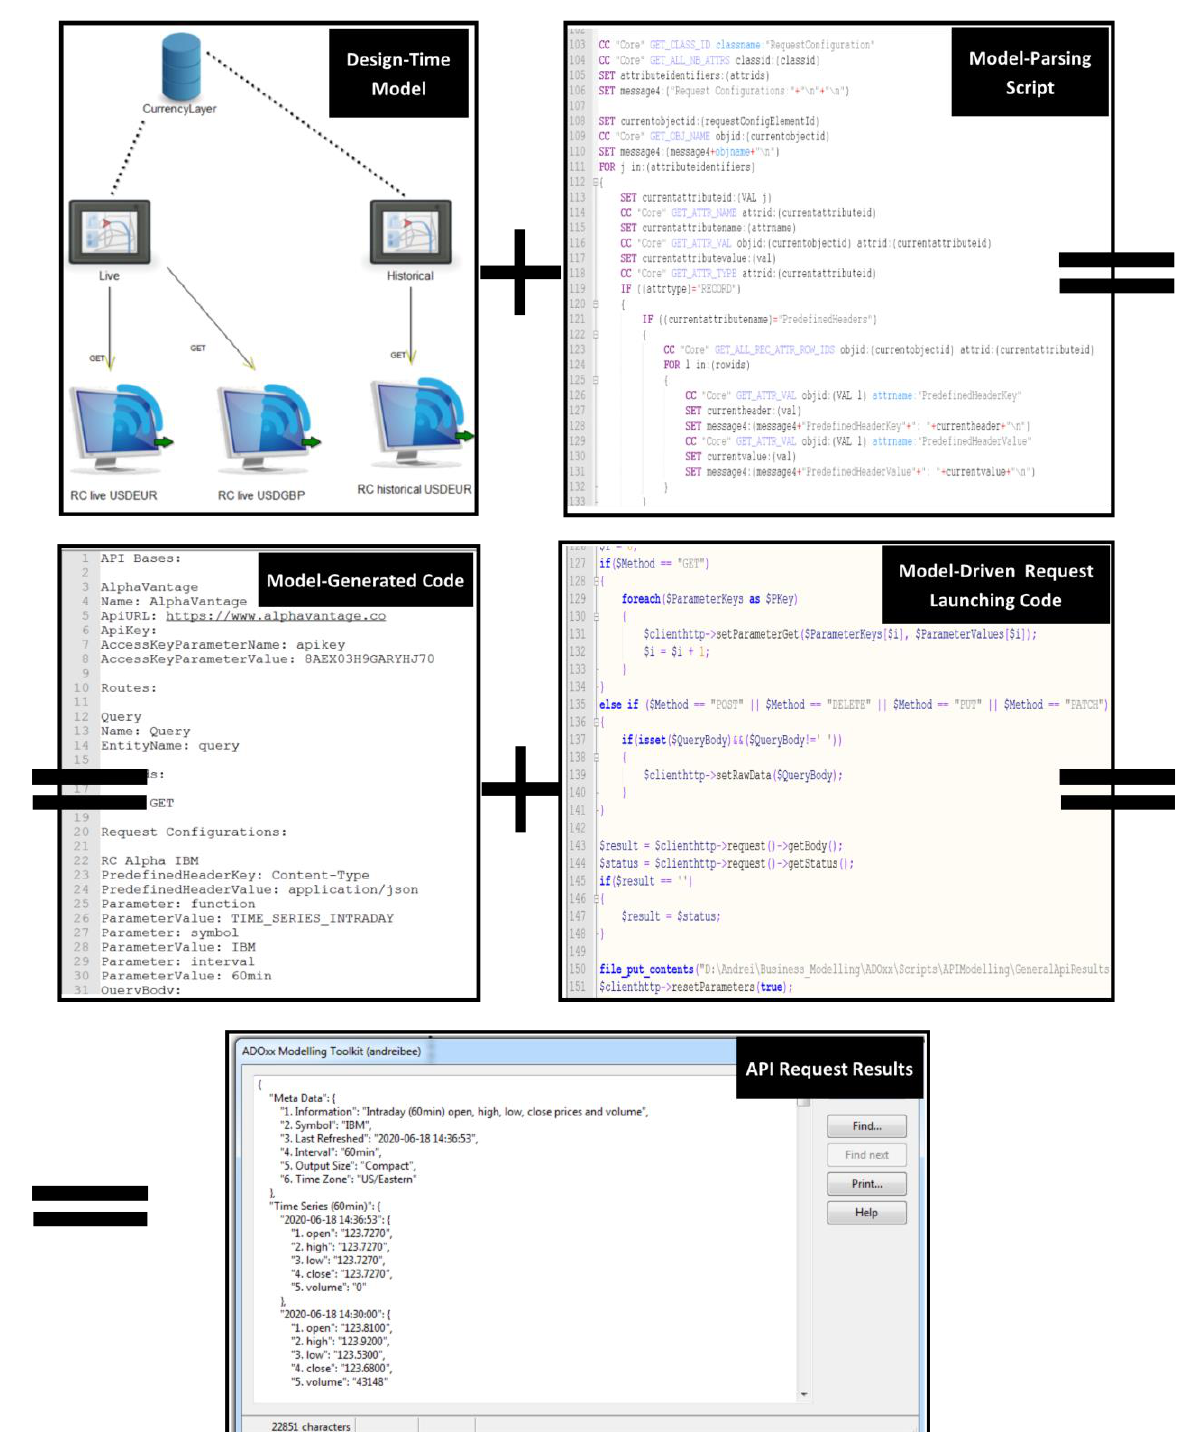
Figure 9. The model-driven API request execution